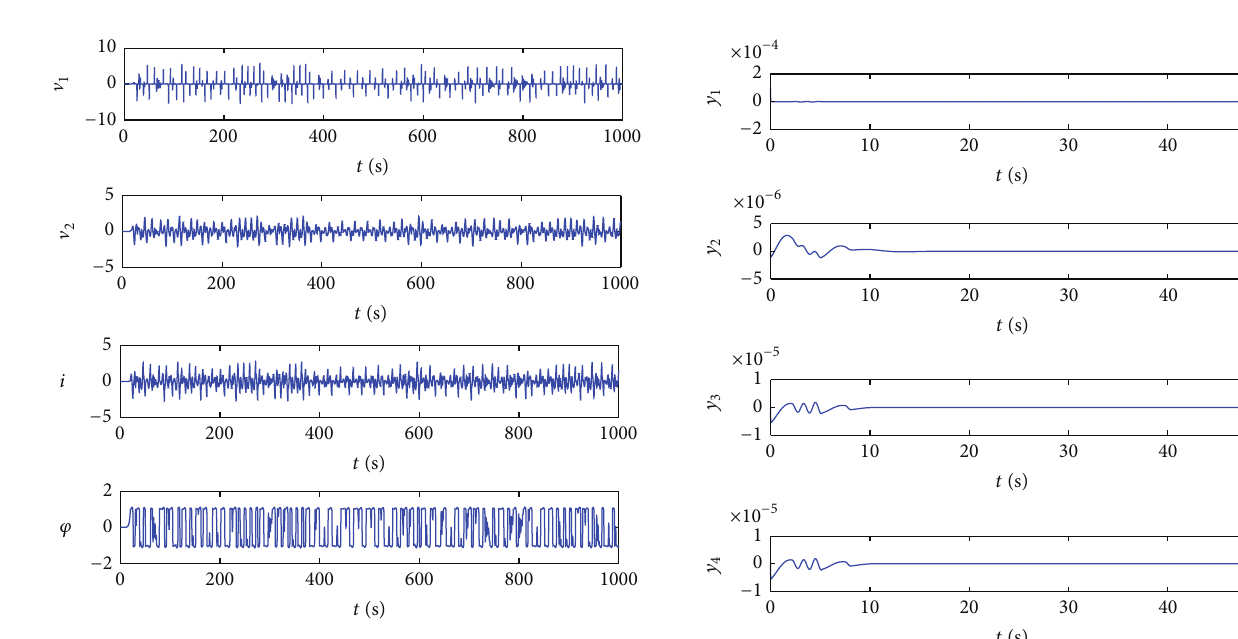
Figure 8: Control to the equilibrium point (0,0,0,1) .